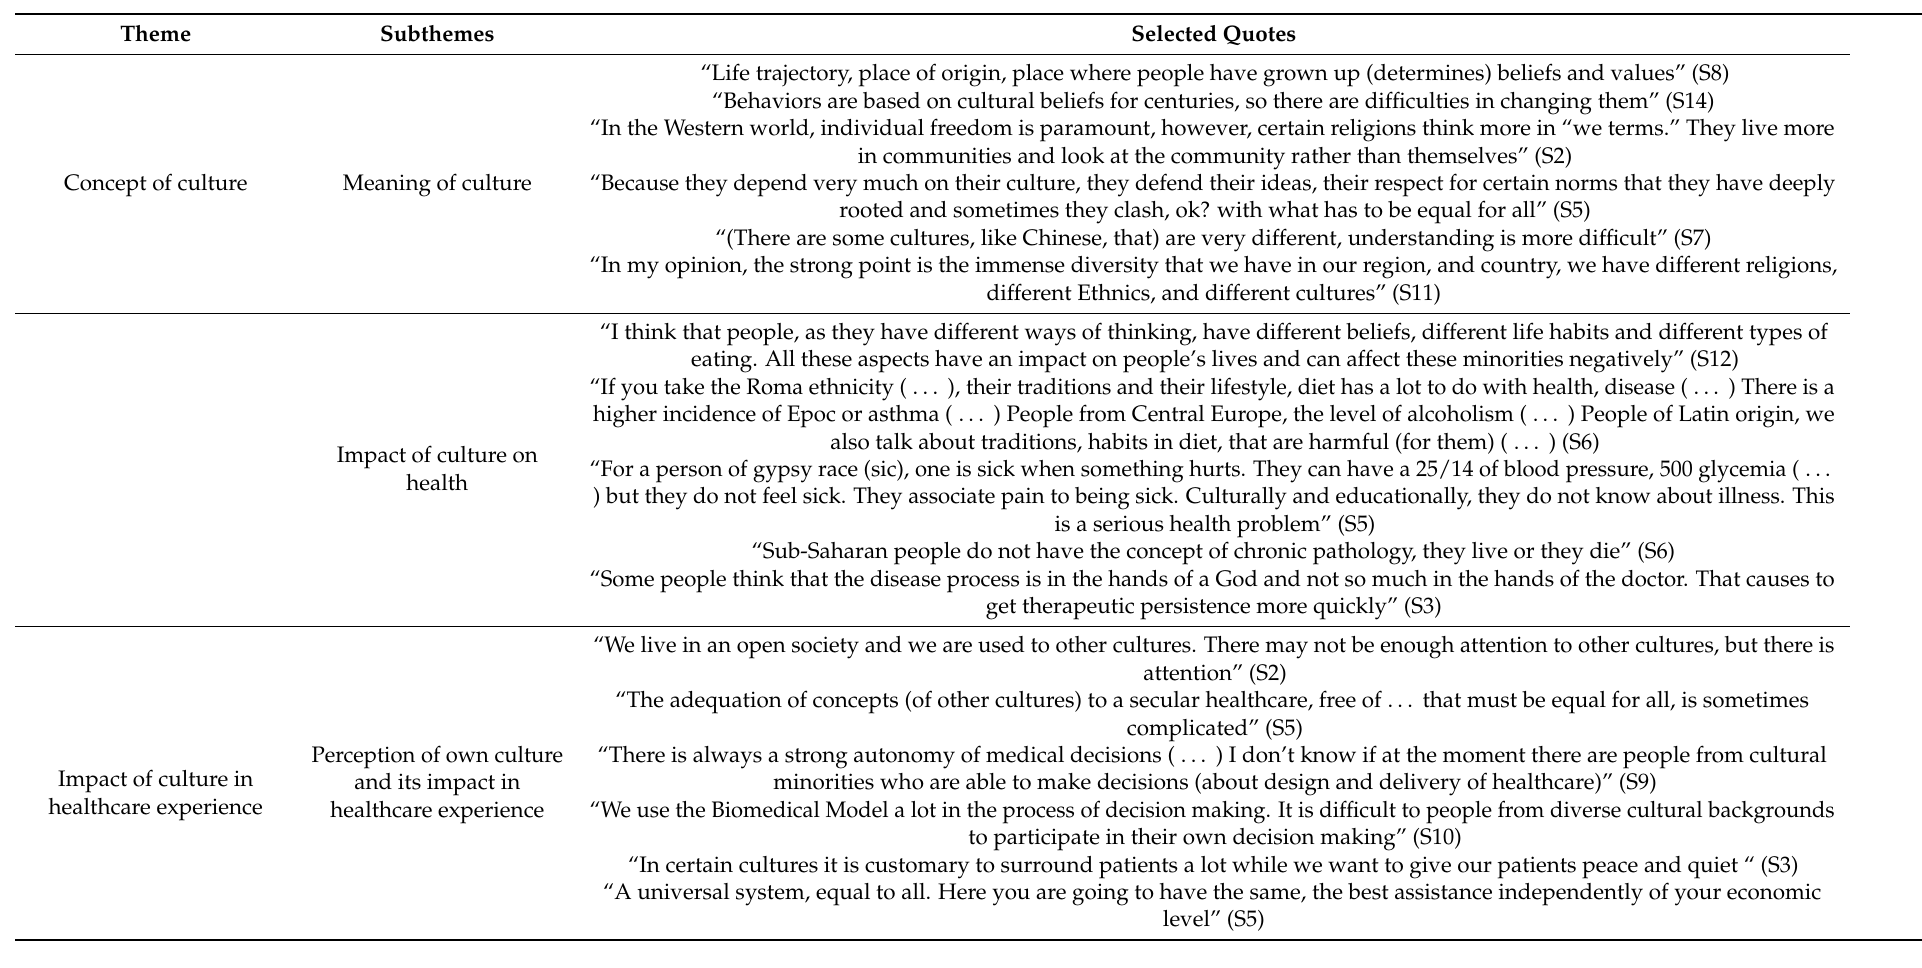
Table A1. Summary of Themes and Subthemes and Example Quotes from the Personal Interviews with